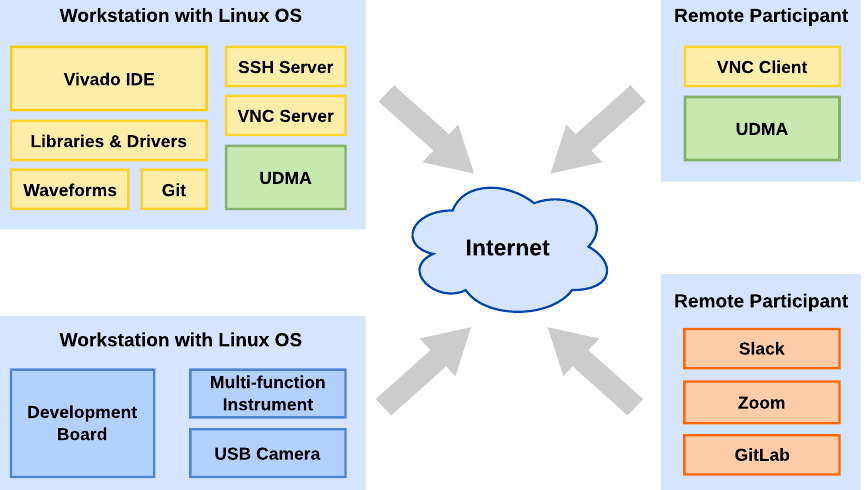
Figure 4. Software applications and tools for the remote